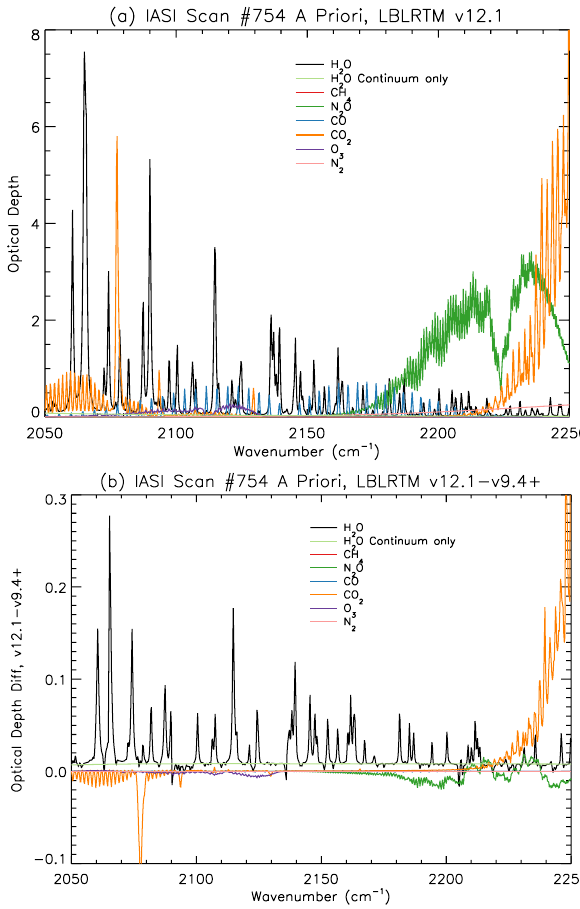
Fig. 28. (a) Convolved optical depth (calculated as the negative of the natural logarithm of the convolved transmittance for LBLRTM runs with a single absorbing gas) for each species near the funda- mental vibrational band of CO. (b) Change in convolved optical depth between LBLRTM v12.1 and LBLRTM v9.4 +